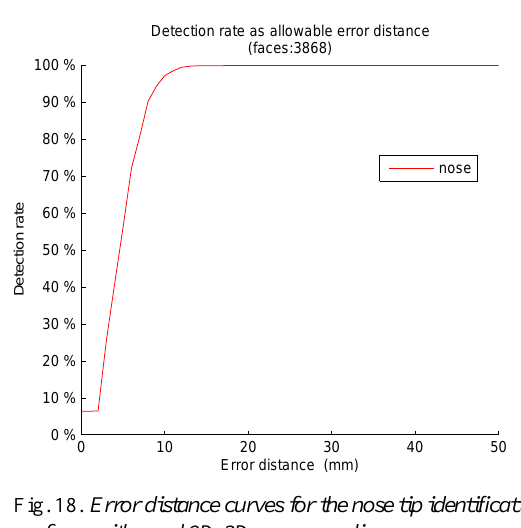
Fig. 18. Error distance curves for the nose tip identification on faces with good 2D-3D corresponding.